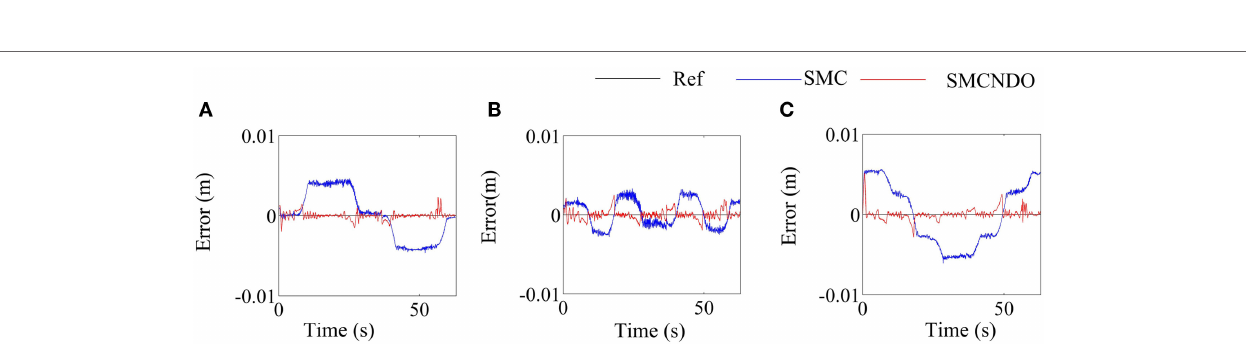
FIGURE 7 | Comparison of tracking errors in the three coordinate directions by implementation of sliding mode control (SMC) and sliding mode control with nonlinear disturbance observer (SMCNDO) when a healthy subject follows a circle-shaped trajectory. (A) Tracking errors in the X direction by implementation of SMC and SMCNDO, (B) tracking errors in the Y direction by implementation of SMC and SMCNDO, and (C) tracking errors in the Z direction by implementation of SMC and